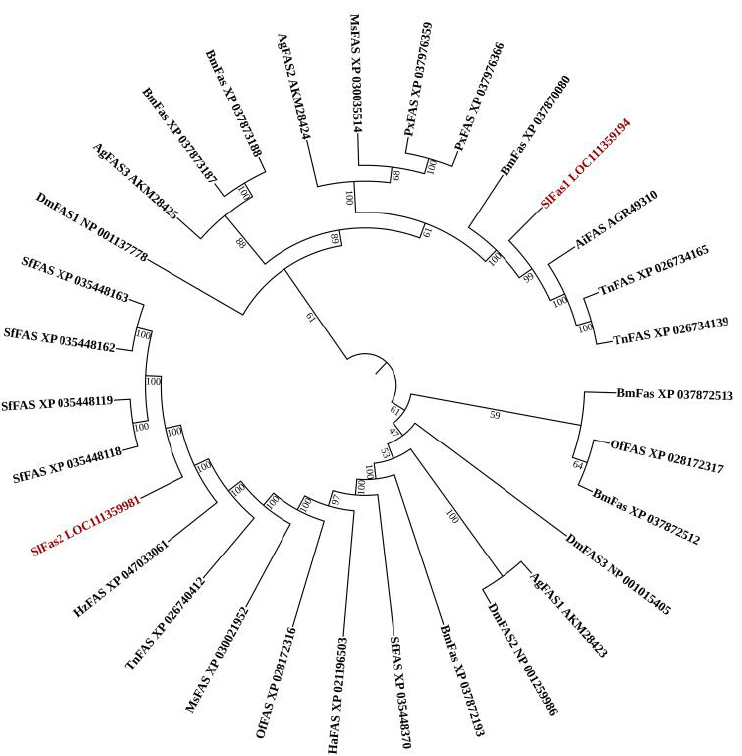
Figure 2. Phylogenetic tree of FAS amino acid sequences in different species. Spodoptera litura (Sl), Bombyx mori (Bm), Drosophila melanogaster (Dm), Spodoptera frugiperda (Sf), Helicoverpa zea (Hz), Trichoplusia ni (Tn), Ostrinia furnacalis (Of), Helicoverpa armigera (Ha), Plutella xylostella (Px), Agrotis ipsilon (Ai).